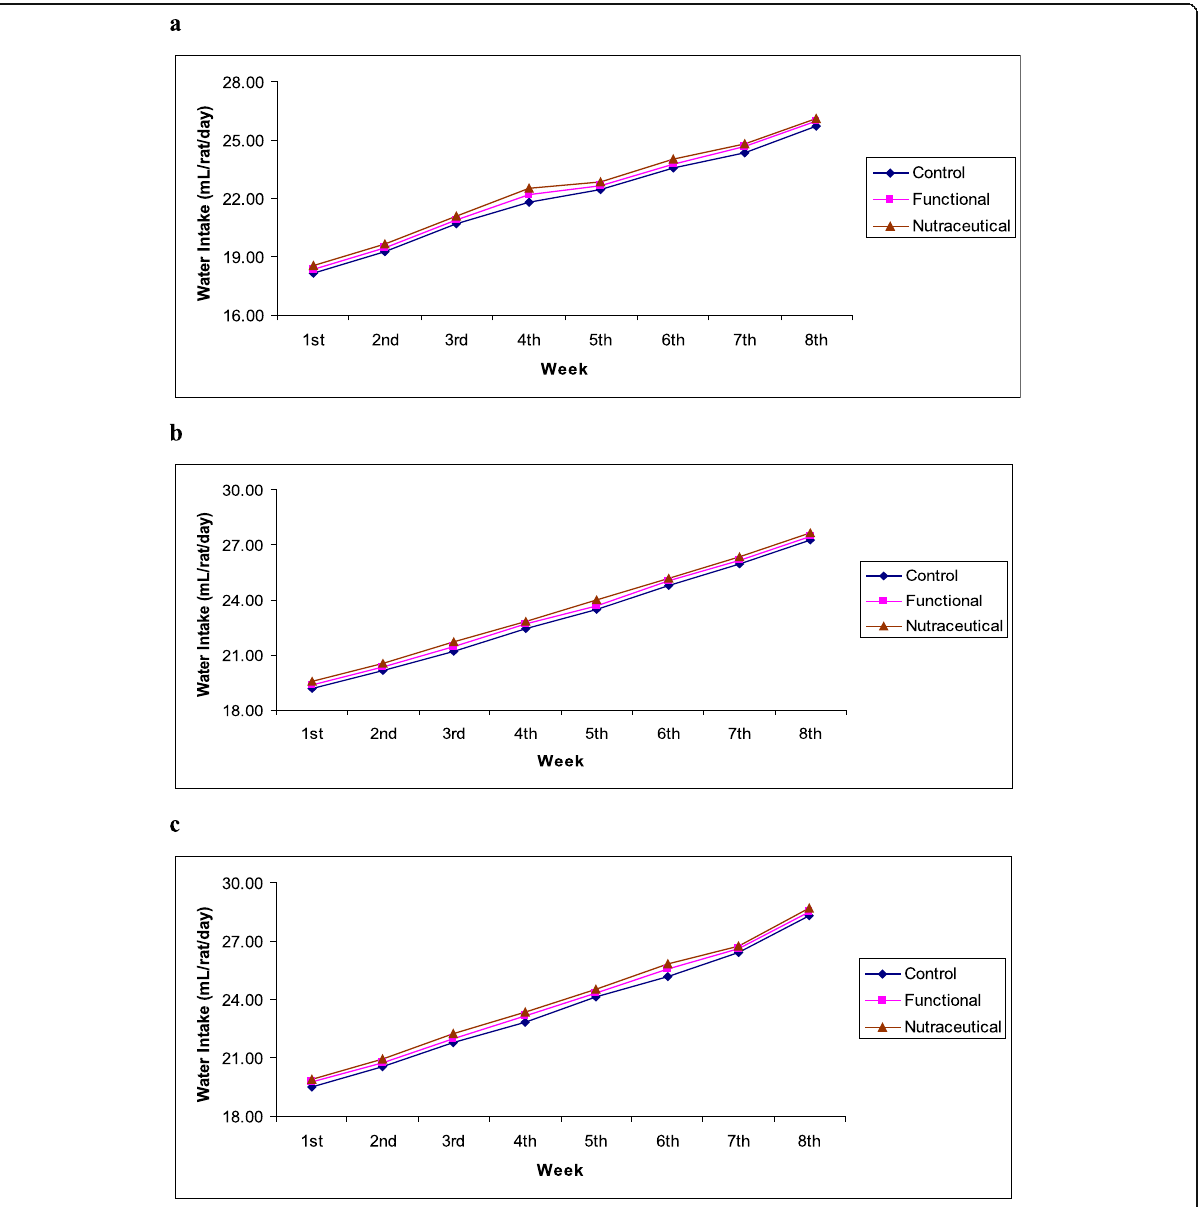
Fig. 2 Water intake in different studies (mL/rat/day) ( a ) Study I: Normal rats; ( b ) Study II: Hyperglycemic rats; and ( c ) Study